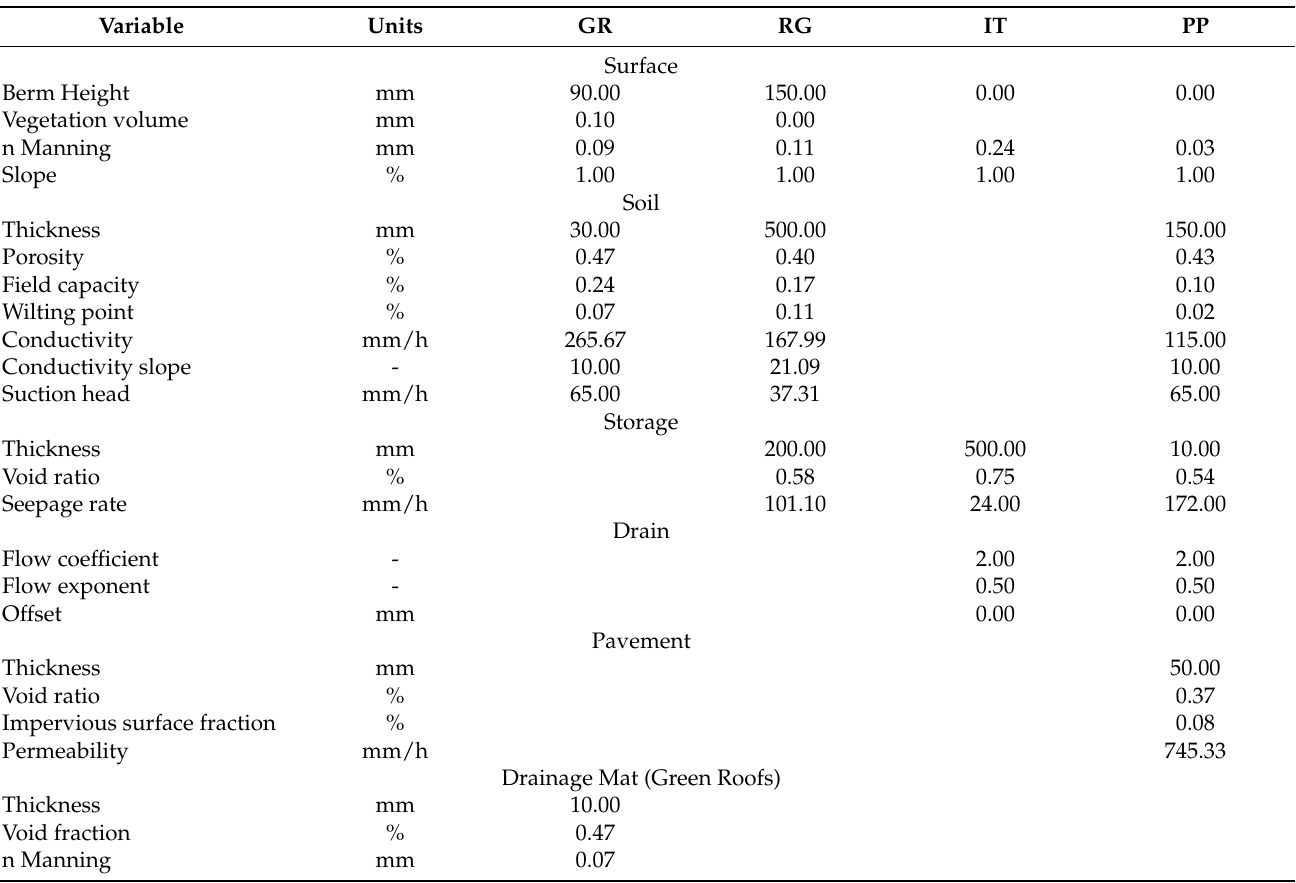
Table 3. Design parameters used in the EPA SWMM LID editor for green roofs (GR), rain gardens (RG), infiltration trenches (IT, and permeable pavements (PP).